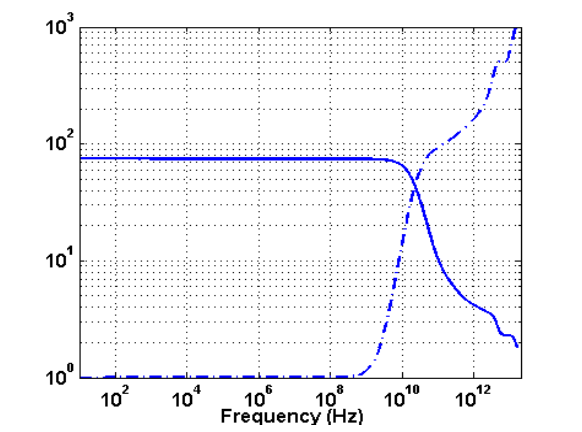
Fig.2: The electrical properties of the aqueous phase: solid line: real permittivity, dash-dotted line: effective conductivity.